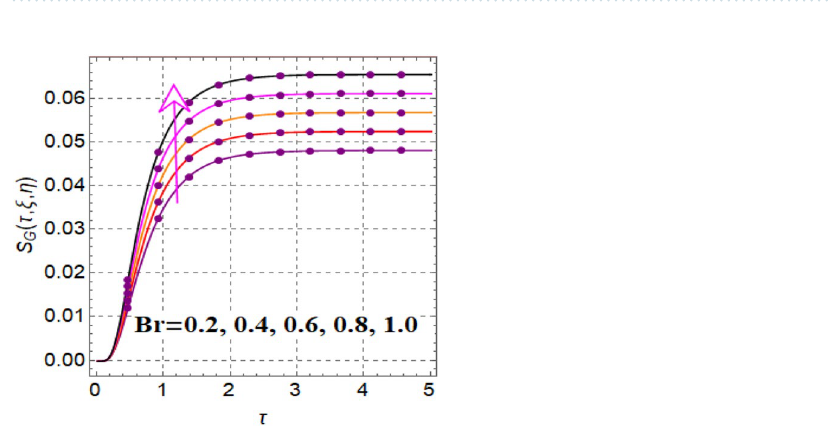
Figure 13. S G (τ , ξ , η) via Nt .